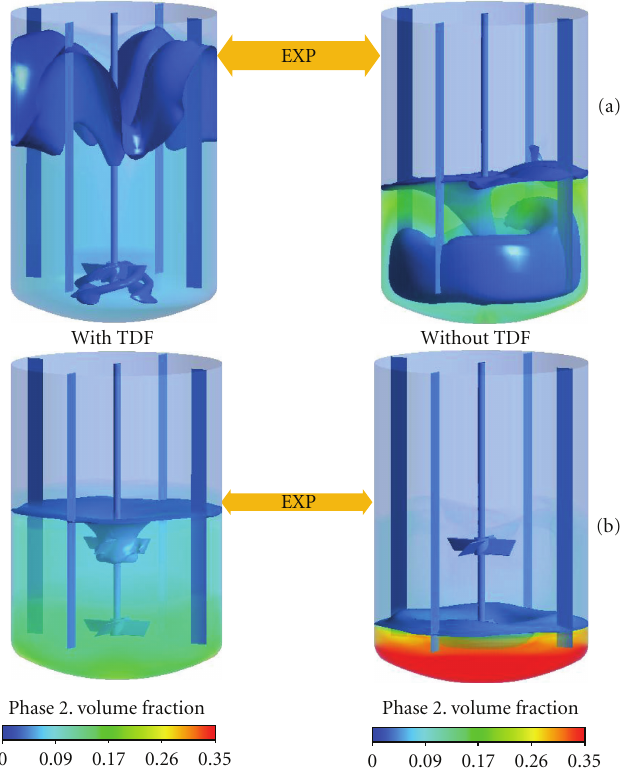
Figure 8: E ff ect of turbulent dispersion force (TDF). Volume rendered plots with isosurface for (a) single-impeller, 10% (w/w) loading, 400RPM and (b) dual-impeller, 15% (w/w) loading, 150 RPM. The double-headed arrows marked “EXP” represent the location of experimental observation with arrow thickness representing the observed 8% spread in the experimental data. Gidaspow drag model.